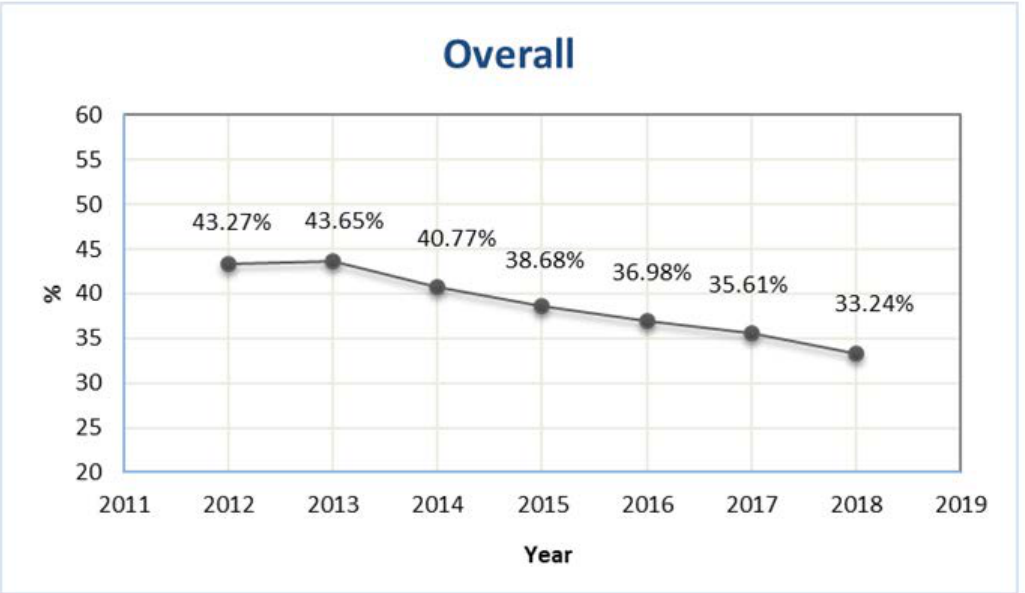
Figure 1. Prevalence of outpatients older than 65 years exposed to at least one potentially inappropri- ate prescription in Piedmont in the period